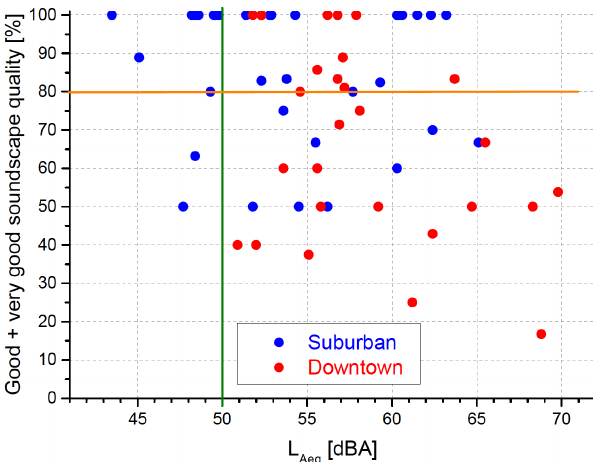
Figure 8: Percentage of respondents rating the perceived sound- scape either good or very good.